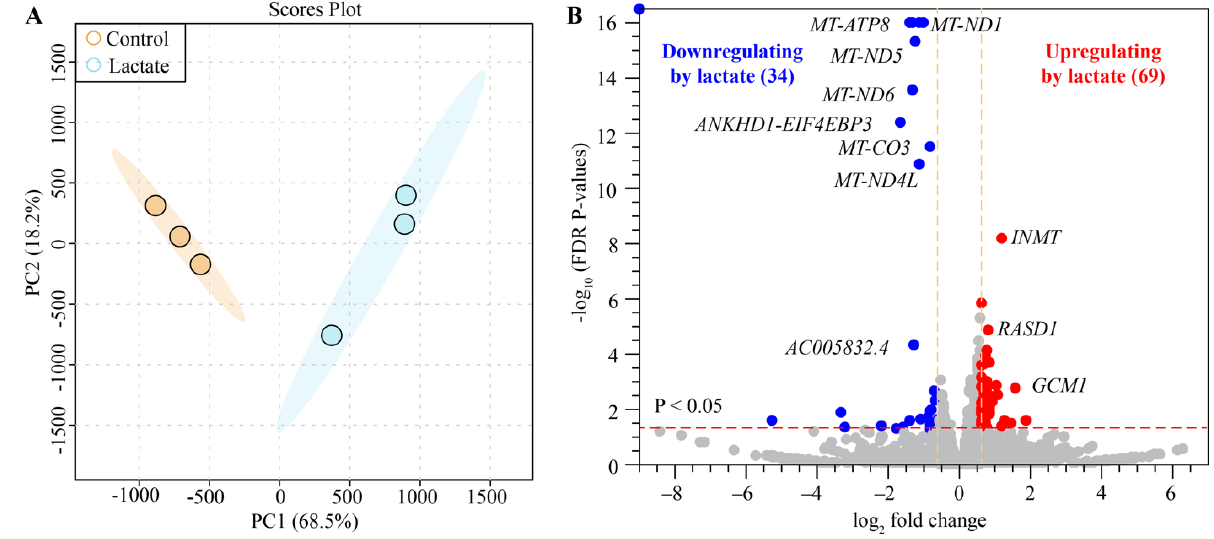
Figure 4. Comparison of the transcriptomes of the Caco-2 cells of the lactate and the control treat- ments. ( A ). Principal component analysis (PCA) scores of the complete expression profiles of all the samples (N = 3). The light blue region is for the 95% confidence interval of the lactate treatment; the light orange region is for the 95% confidence interval of the control group; and the light blue and orange dots are representative of the samples of the lactate and the control treatments, respectively. ( B ). Volcano plot showing the differentially expressed genes (DEGs) in the Caco-2 Cells of the lactate and the control treatments. The FDR-corrected p < 0.05; the absolute fold change >= 1.5. The blue dots are the downregulated DEGs, and the red dots are the upregulated DEGs caused by the lactate treatment. The gray dots are the genes with no difference in